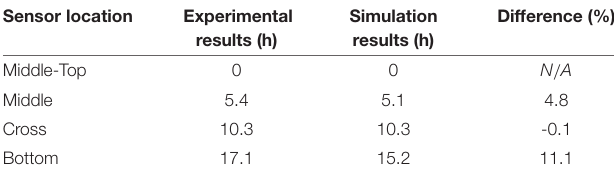
TABLE 4 | Comparison between experimental and simulation primary drying time for cycle 2.